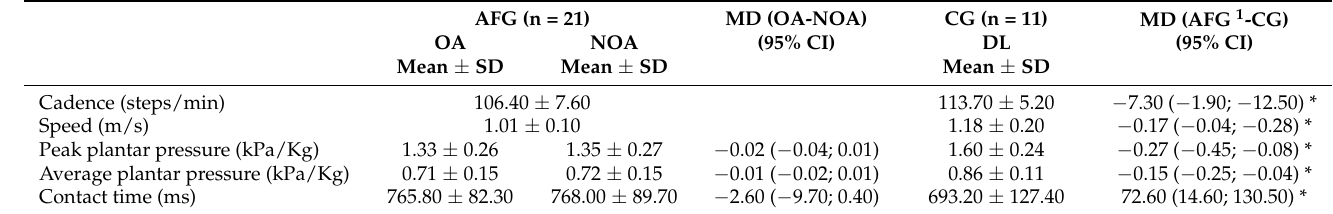
Table 5. Intra-group difference (AFG) between operated ankle/non-operated ankle and between groups (AFG-CG) of gait parameters and dynamic plantar pressure at 12 months post-surgery. AFG (n = 21)